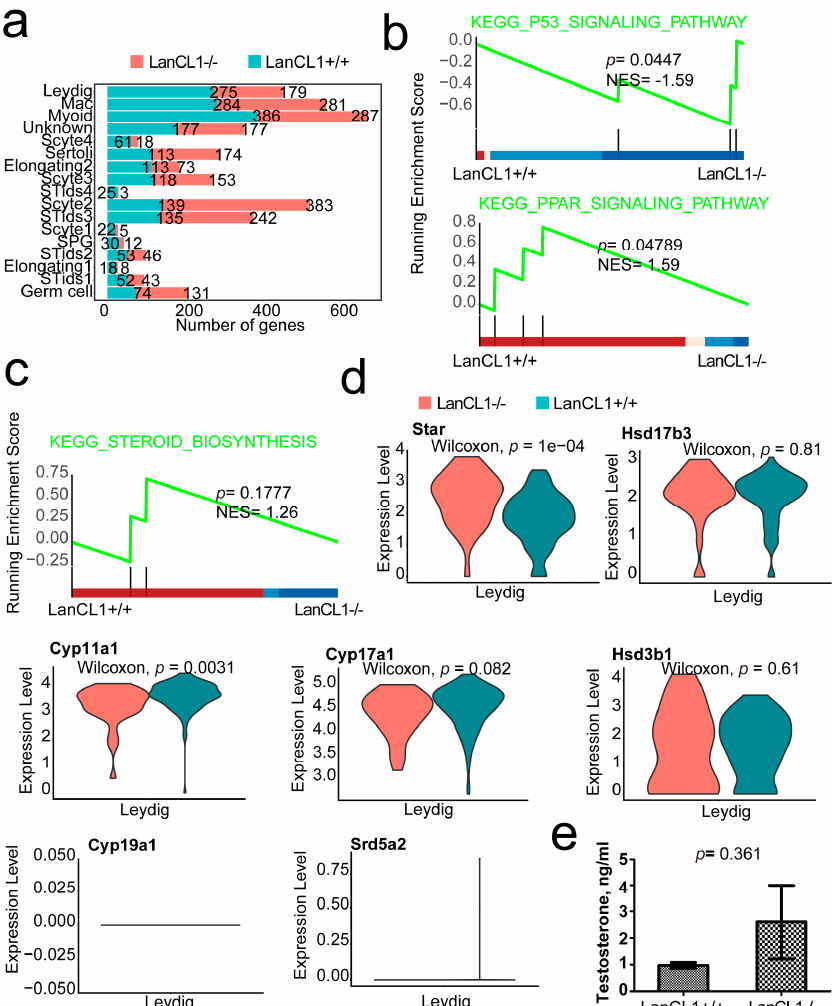
Figure 5. LanCL1 gene regulated the P53 and PPAR signaling other than the testosterone synthesis in the Leyding cells. ( a ) The numbers of DEGs in every cell clusters. ( b ) The GSEA of the DEGs in the LanCL1 +/+ and LanCL1 − / − mice of Leydig cell. ( c ) The steroid biosynthesis. ( d ) The marker genes of testosterone biosynthesis. ( e ) Serum testosterone level in the LanCL1 +/+ and LanCL1 − / − mice.